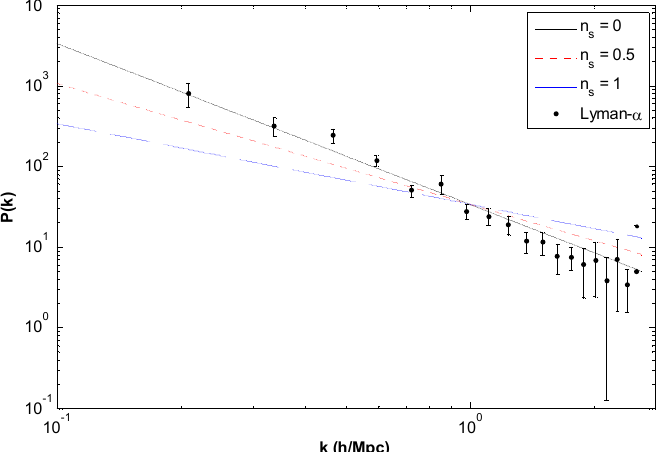
Figure 1 . Matter power spectrum on small scales, for various 𝑛 (cid:3046) with 𝑄 (cid:3404) 0 and 𝑁 (cid:3046) (cid:3404) 3 (cid:3400) 10 (cid:2876) , compared to Lyman- 𝛼 data from eBOSS DR14 [20] compiled in repository here †